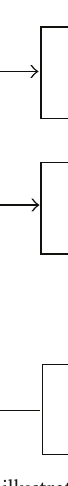
Figure 1: An illustration of our proposed